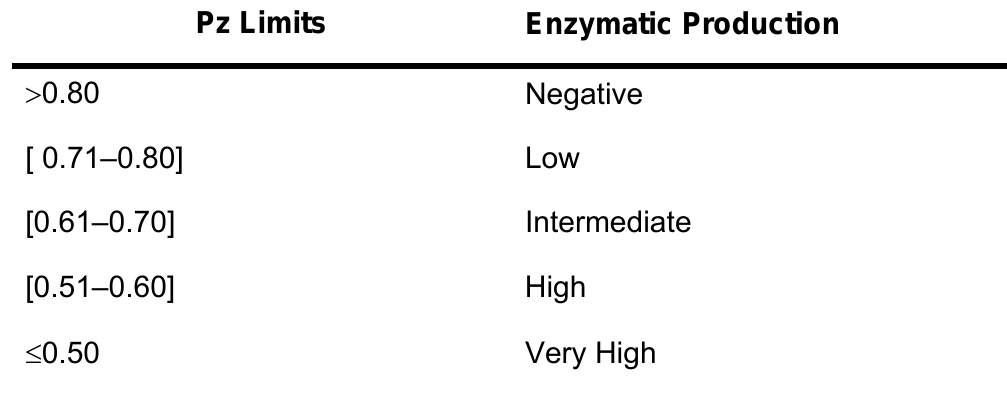
Table 2. Characterization of phospholipase activity (Pz), as a function of the ratio between colony diameter (Dc) and colony diameter plus precipitation zone diameter (Dc +